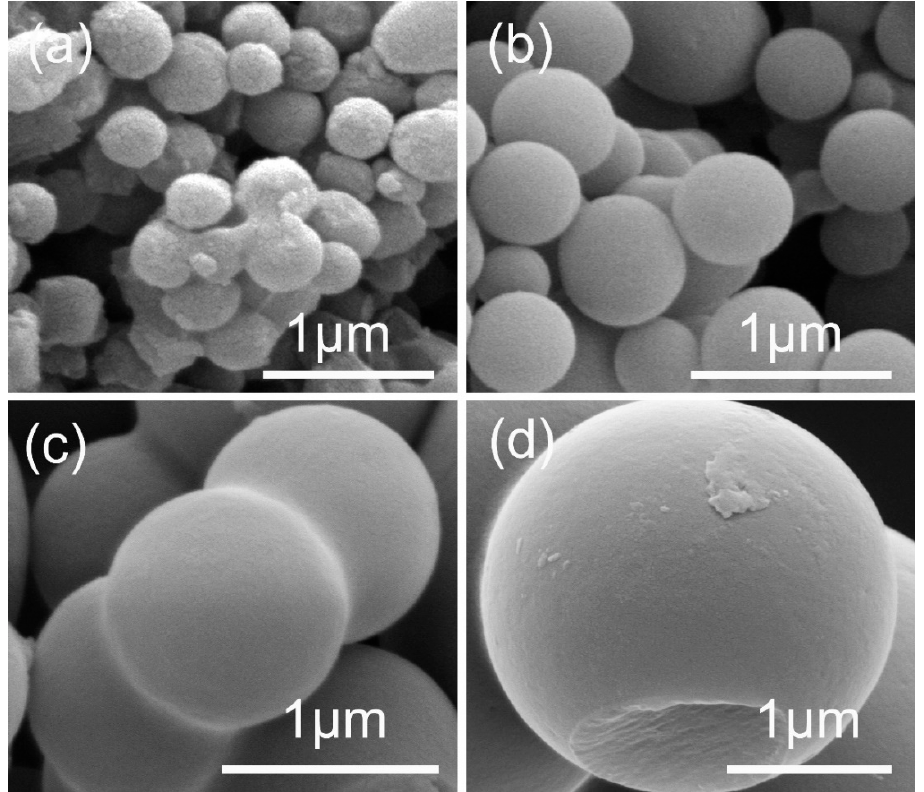
Figure 1. SEM images of carbonaceous spheres of different size prepared by varying the concentration of sucrose: ( a ) 0.5 M; ( b ) 0.75 M; ( c ) 1 M; ( d ) 2 M.